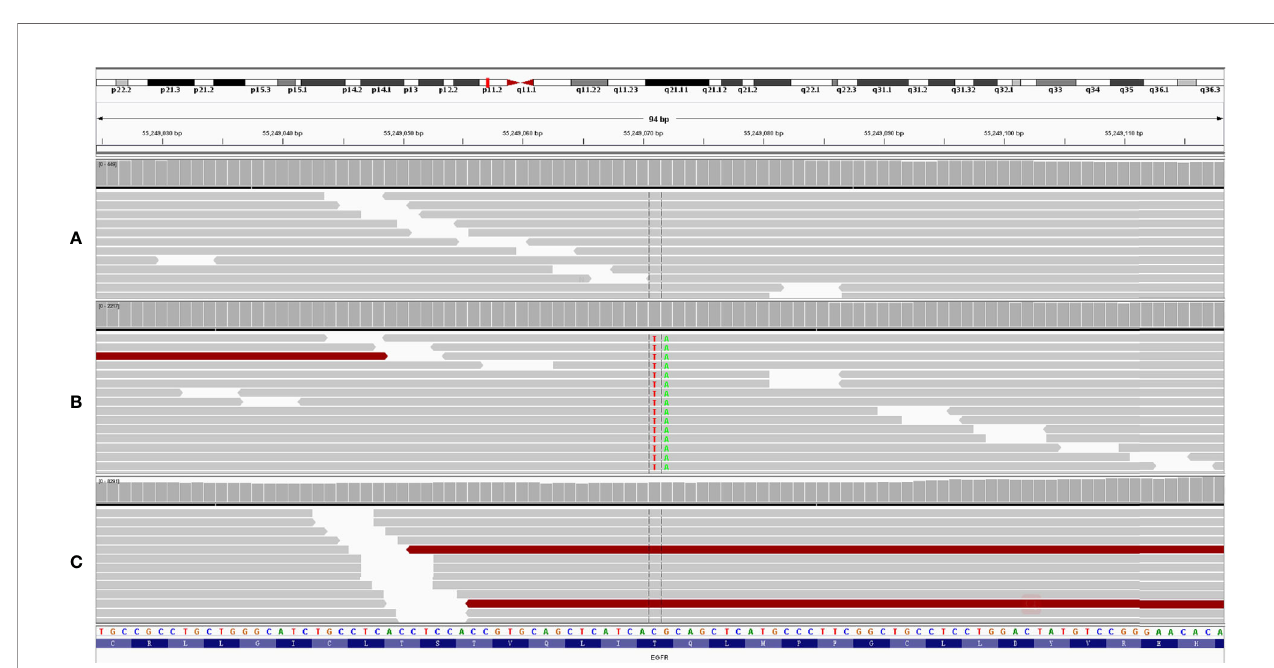
FIGURE 3 | A novel EGFR T790I mutation was detected after icotinib treatment for 18 months (B) . This mutation disappeared after osimertinib treatment for 16 months (C) . White blood cell was used as control (A)